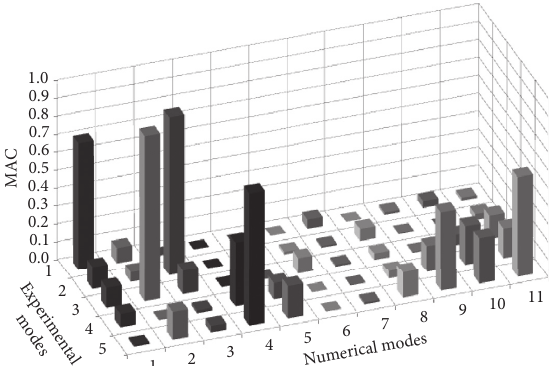
Figure 6: Model without equivalent struts: histogram represen- tation of the MAC